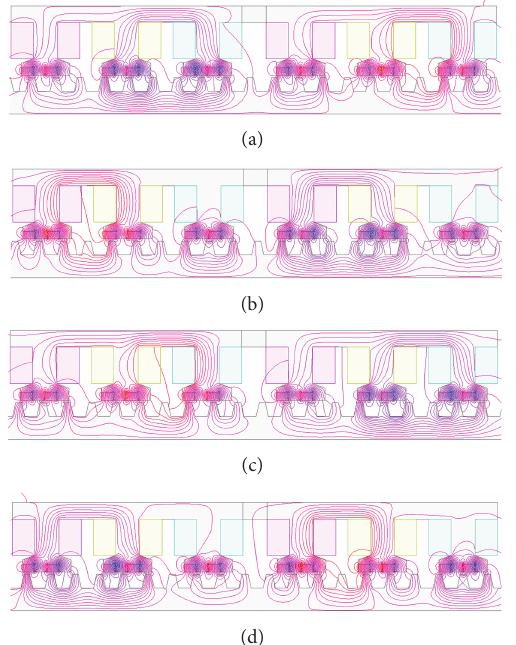
Figure 6: No-load magnetic field distributions at different stator positions. (a) Position A . (b) Position B . (c) Position C . (d) Position D .